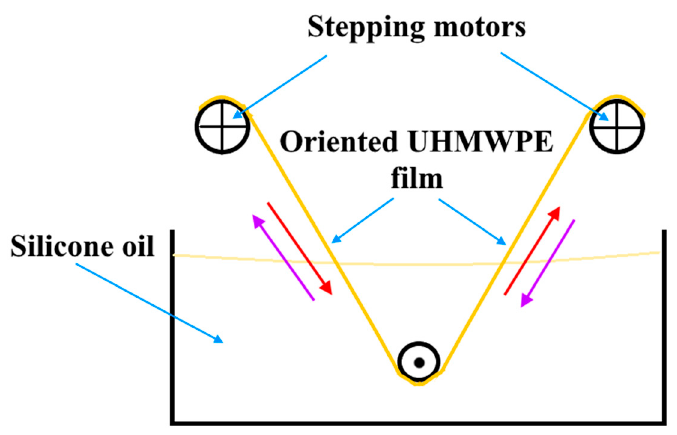
Figure 1. Orientation and drawing process for the UHMWPE films in a silicone oil bath.